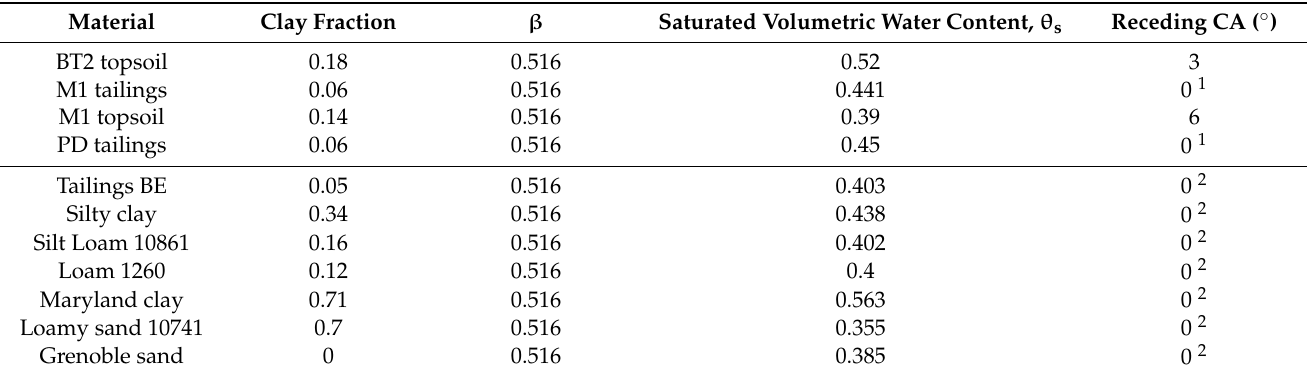
Table A5. Parameters used in the Chang-Cheng-Qiao model (CCQ) for each material: clay fraction, parameter β , saturated volumetric water content ( θ s ), and receding contact angle